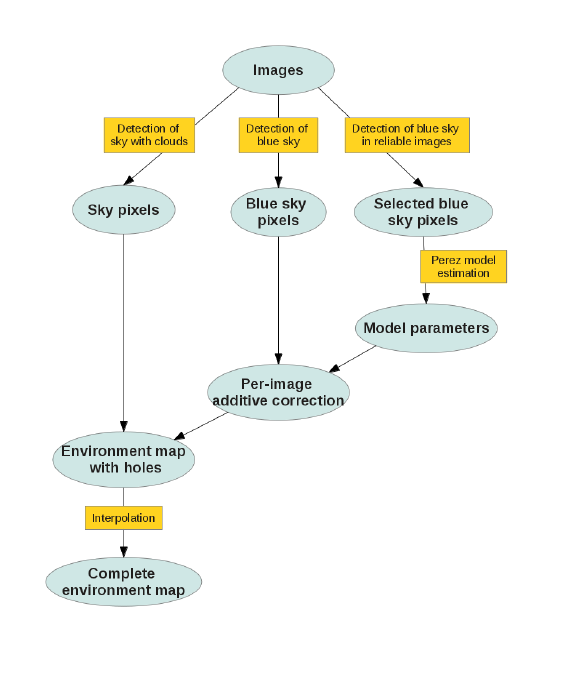
Figure 7: The steps of the proposed